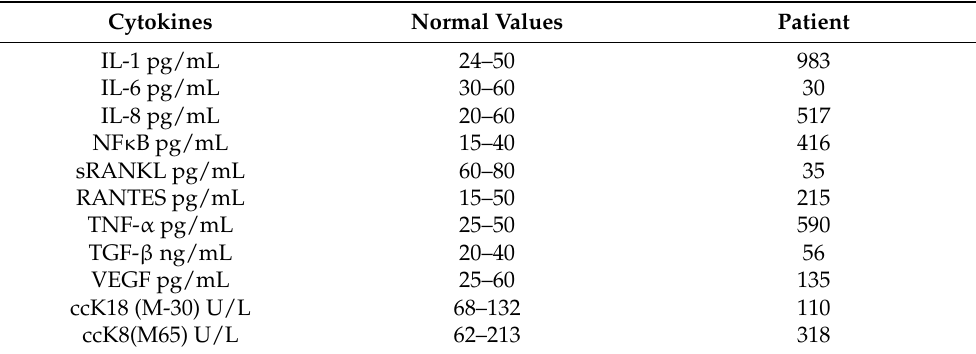
Table 2. Levels of cytokines, chemokines, apoptosis and necrosis markers released by lymphocytes exposed to liraglutide in the media. Cytokines Normal